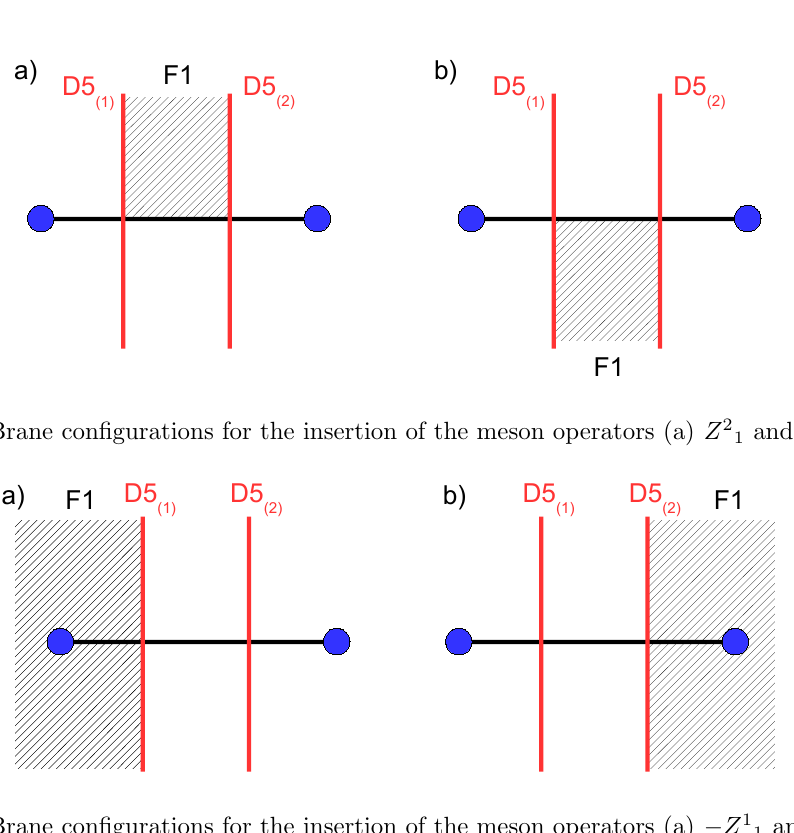
Figure 6 . Brane con(cid:12)gurations for the insertion of the meson operators (a) (cid:0) Z 1 1 and (b) Z 2 2